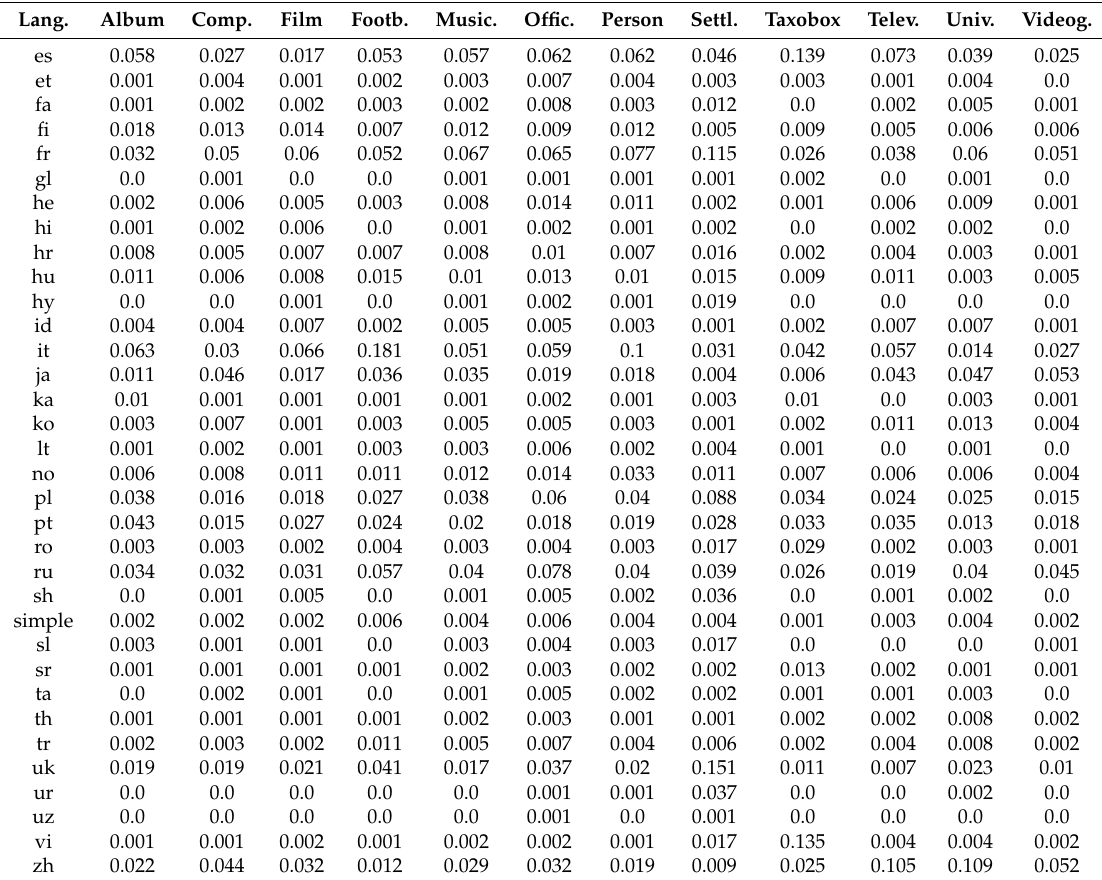
Lang. Album Comp. Film Footb. Music. Offic. Person Settl. Taxobox Telev. Univ. Videog.